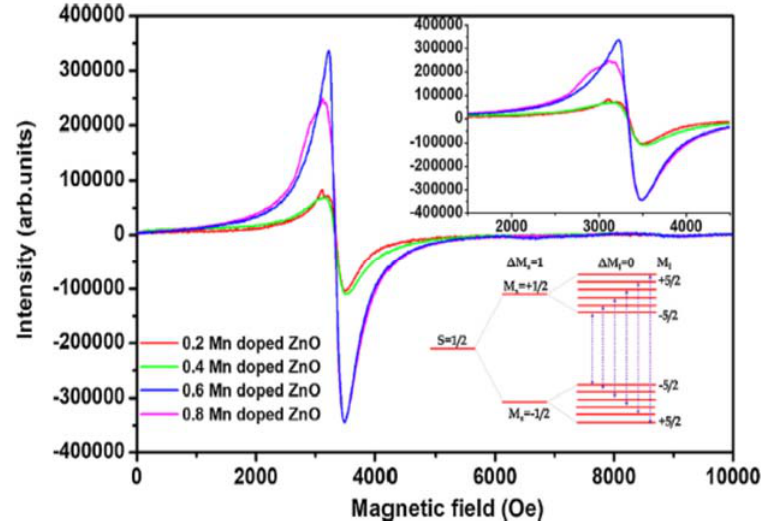
Figure 13. ESR spectra of Mn-doped ZnO as a function of Mn contents (The Figure was reproduced with copyright permission from reference [98]).